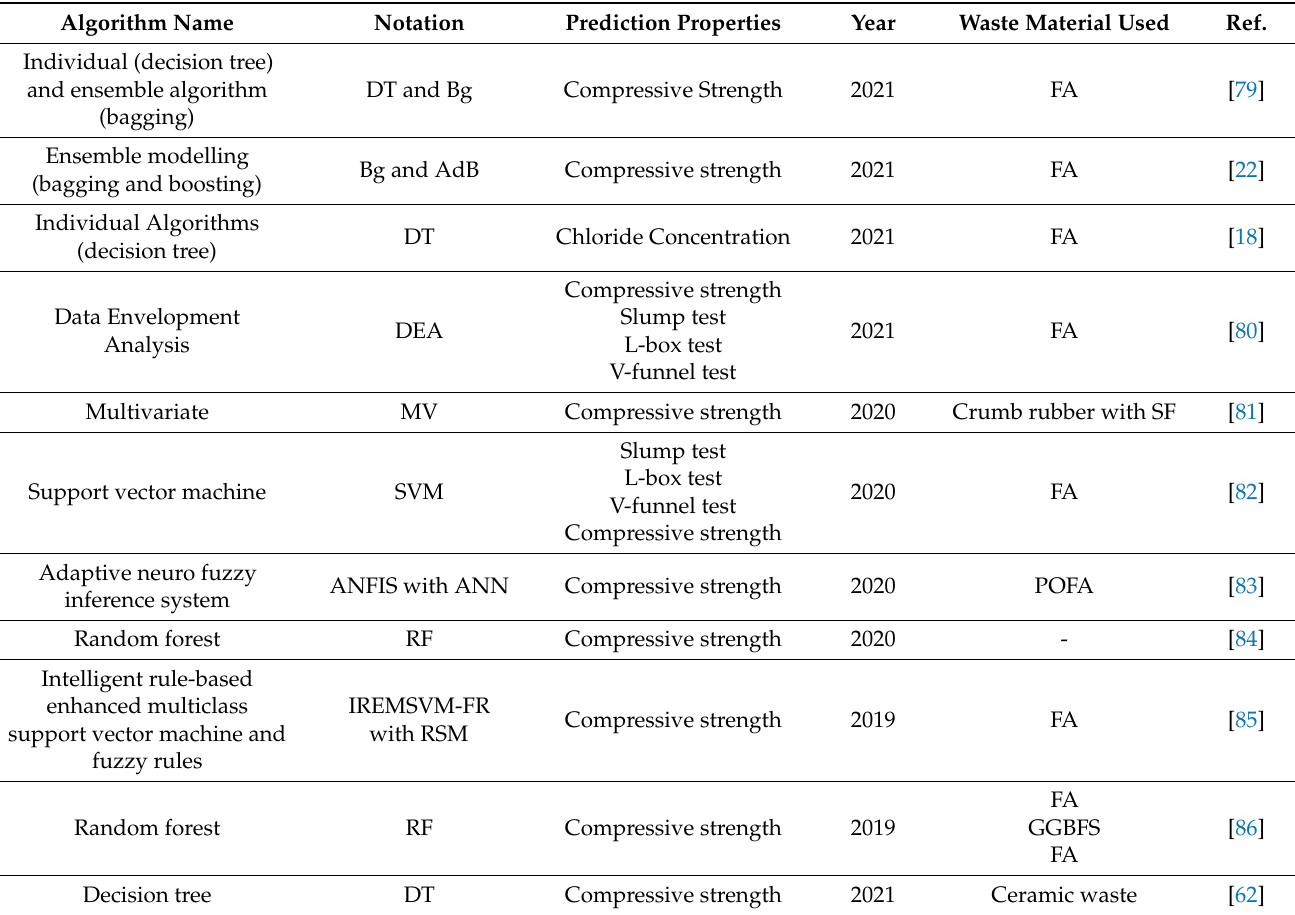
Table 1. Machine learning algorithms in the